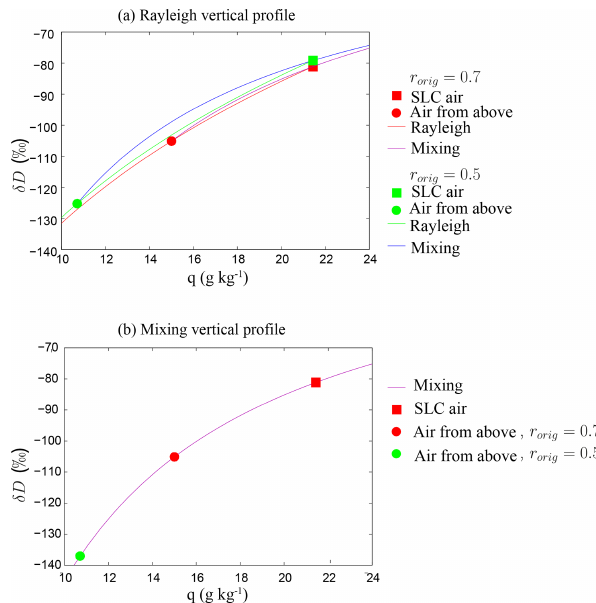
Figure 4. Idealized q − δD diagrams showing how the SCL water vapor δD is set, for the case where the tropospheric δD profile fol- lows Rayleigh distillation (a) or a mixing line (b) . For this illustra- tive purpose, we assume SST = 30 ◦ C, h 0 = 0 . 8, δD oce = 0‰, and φ = η = 0. In (a) , the red curve shows the Rayleigh profile starting from the SCL and the purple curve shows the mixing line connect- ing the air coming from above to the surface evaporation, in the case r orig = q orig /q 0 = 0 . 7. The green curve shows the Rayleigh profile starting from the SCL and the blue curve shows the mixing line con- necting the air coming from above to the surface evaporation, in the case r orig = q orig /q 0 = 0 . 5. One can see that when r orig is lower, the mixing line is more curved, leading to more enriched values. In (b) , the purple curve joins the SCL air and the air at all altitudes above the SCL. One can see that different values for r orig can lead to the same value of δD in the